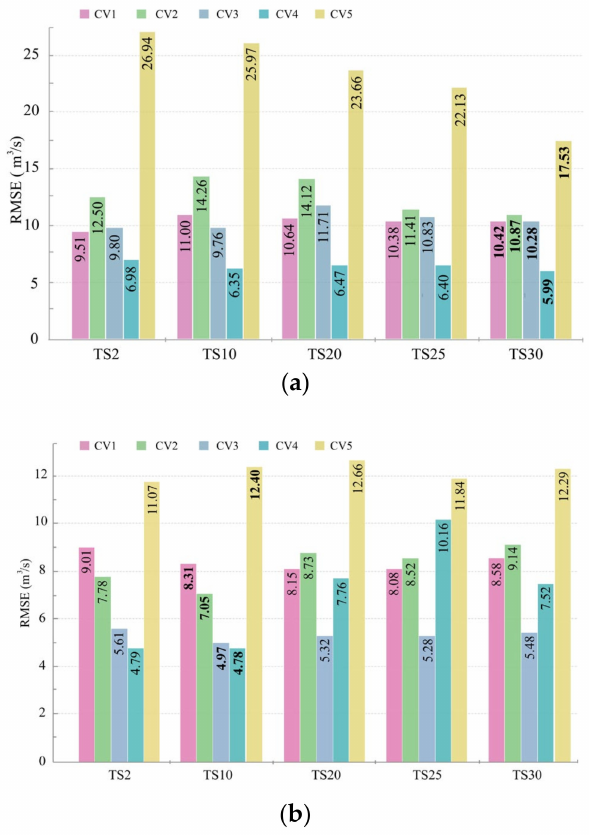
Figure 10. Comparisons of model predictions in different time steps and different data splitting during the testing phase using approach 3 ( a ) LSTM. ( b ) FFS-LSTM.